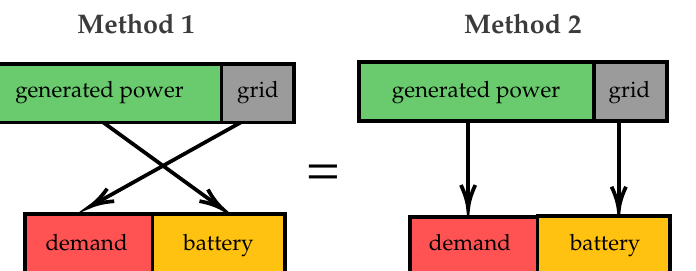
Figure 4. Covering demand using the grid and charging the battery with generated power is the same as charging the battery using the grid and covering demand using generated power, based on examining the overall (dis)charging inefficiencies and cost of importing.